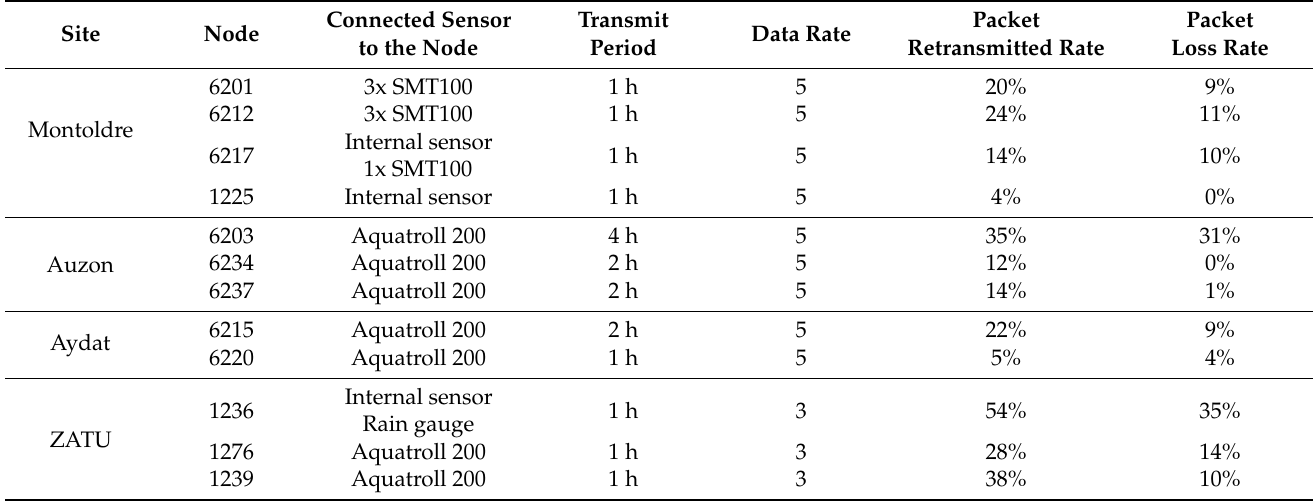
Table 3. Packet retransmitted and packet loss rate for each node deployed on the experimental sites, as well as their configuration (connected sensors, transmit period, and data